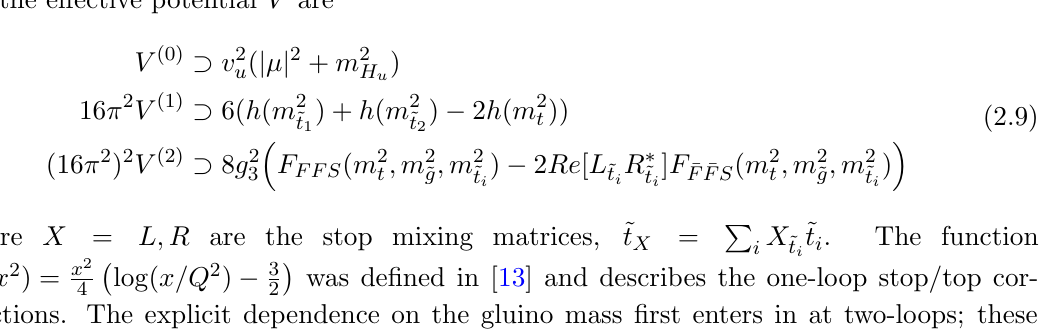
Figure 2 . Relevant transfer matrix coe(cid:14)cients for M 3 (solid blue) and m 2 the messenger scale (cid:3), for Q = 1 TeV and tan (cid:12) = 20. Note that A other